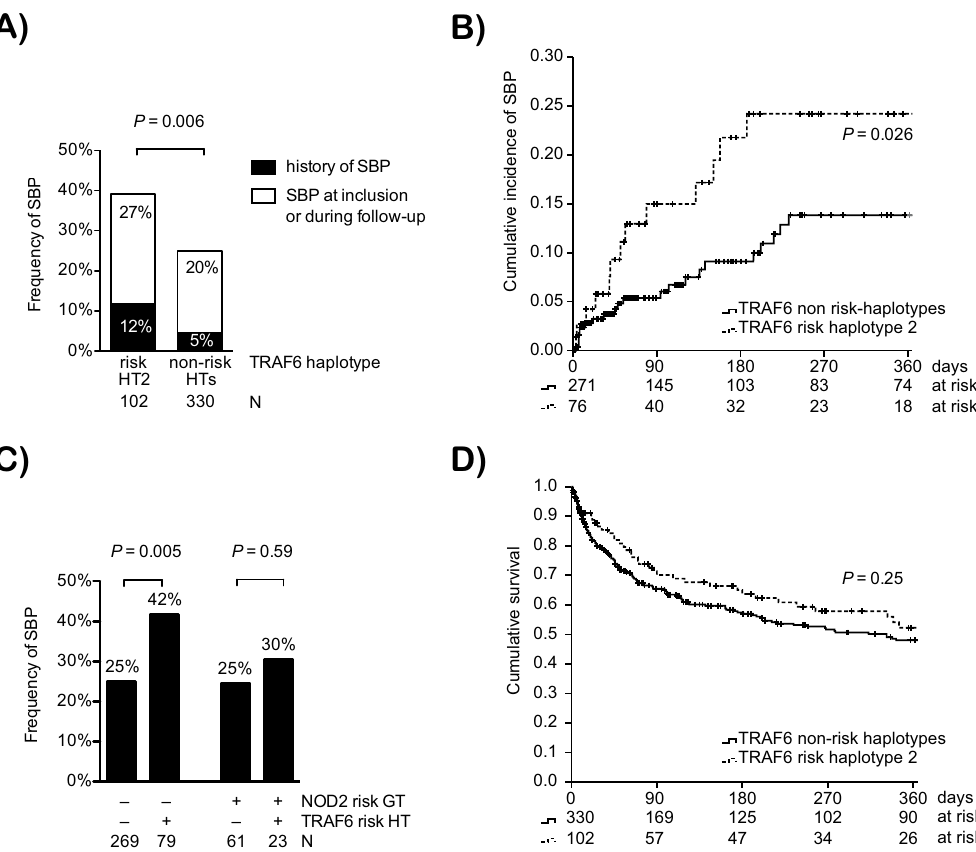
Figure 2. Association of TRAF6 haplotypes with SBP and survival. ( A ) Combined prospective and retrospective analysis. Frequency of SBP in patients stratified for the presence of the TRAF6 risk haplotype 2 (HT2) and other haplotypes (non-risk HTs). The frequency of SBP is given for SBP, which were well documented at baseline (history of SBP) and, which were diagnosed at inclusion or during follow-up. P value from Fisher’s exact test. ( B ) Prospective analysis. The cumulative incidence of a first episode of SBP in patients without a history of SBP and without SBP at inclusion is indicated and stratified for the presence of the TRAF6 risk haplotype 2. Data were right-censored at liver transplantation, death, or loss-to-follow-up. Patients at risk and the P value from log-rank test are indicated. ( C ) The frequency of SBP in patients stratified for the presence of the TRAF6 risk haplotype 2 (HT2) and other haplotypes (non-risk HTs) is given for patients carrying at least one of the NOD2 risk variants R702W, G908R or L1007fs and for patients with the NOD2 wild-types. P values from Fisher’s exact test. ( D ) Kaplan-Meier analysis of cumulative survival of the overall cohort is shown and stratified for the presence of the TRAF6 risk haplotype 2. Data were right-censored at liver transplantation or loss-to-follow-up. Patients at risk and the P value from log-rank test are